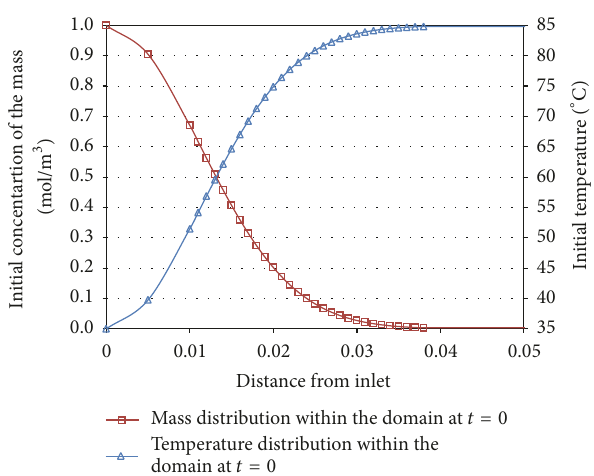
Figure 13: The initial condition for both physics of mass and heat